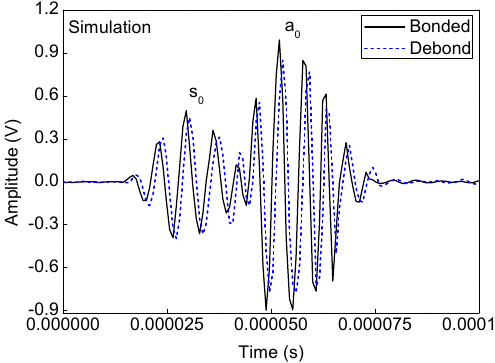
Figure 8. A typical comparison of bonded and debond influenced simulation signals.